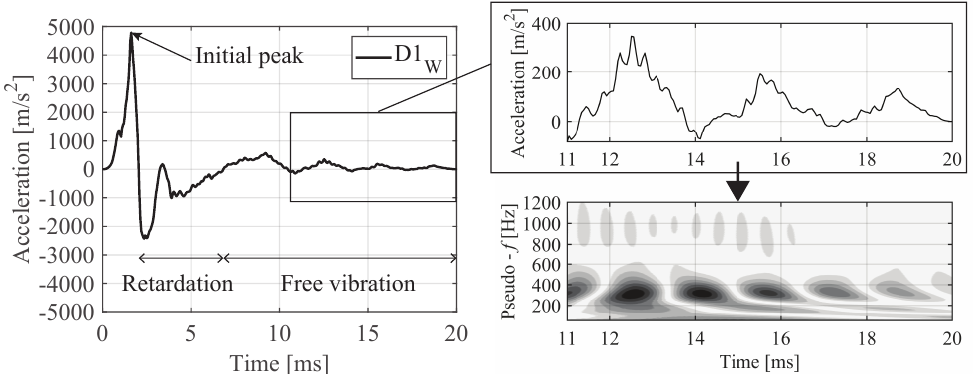
Figure 7. The initial peak; retardation; and linear free vibration phase of Beam D1 and time–frequency scale-space of the linear free vibration phase determined using CWT.